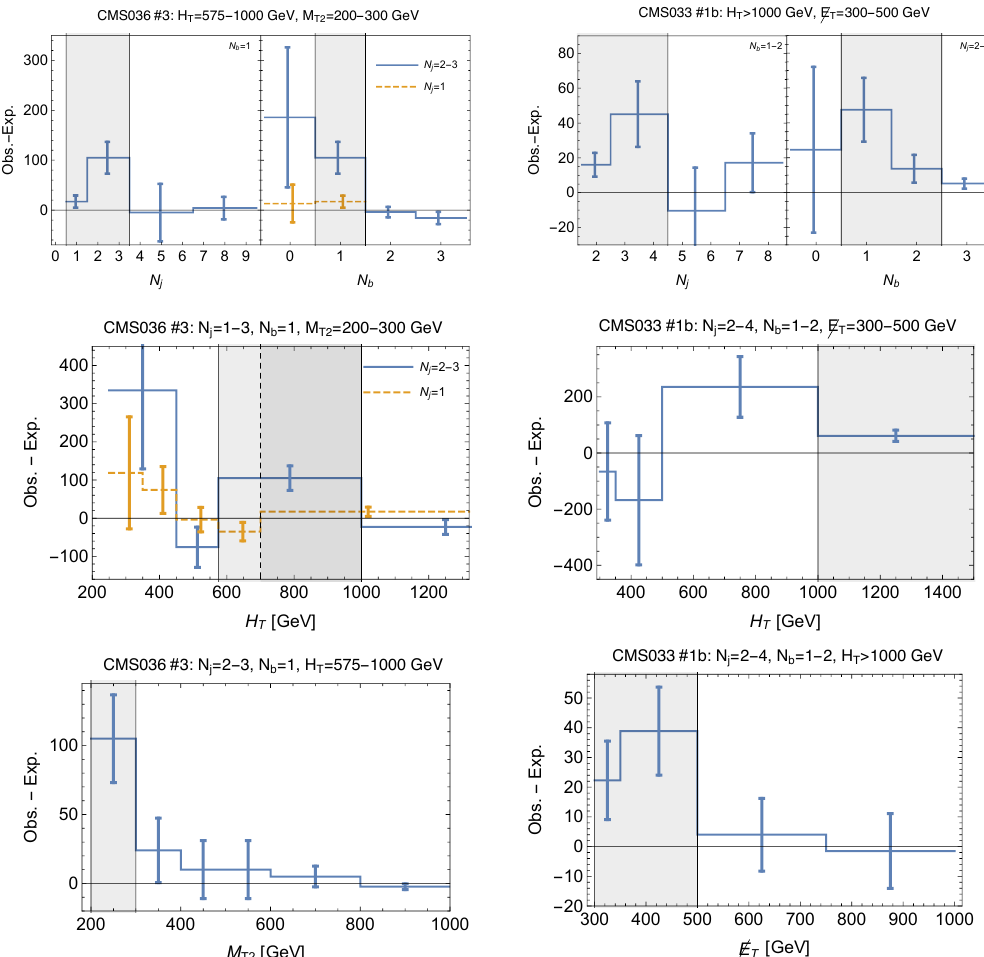
Figure 3 . Distributions of the residuals (observed minus expected counts) for the remaining excesses in tables 1 and 2, with error bars denoting the uncertainty, as explained in the text. The left column shows kinematic distributions for CMS036 ROI #3 while the right column displays CMS033 ROI #1b. The variables plotted and the color-coding are the same as in (cid:12)gure 2. second bin of the N = 1 distribution ( p j 0 = 350 (cid:0) 450 GeV) which only marginally j T increases the signi(cid:12)cance. Finally, the bottom plot shows the M distribution of the T 2 N (cid:21) 2 bins (note that M is not de(cid:12)ned for N = 1). j j T 2 (cid:15) In the right column, we show the kinematic distributions for the very similar CMS033 ROI #2, which is formed by signal regions with low H (cid:24) =E . Four separate signif- T T icant aggregations are possible, of which two are shown in solid blue (#2a), dashed yellow (#2b, which for presentation purposes is rescaled by a factor of 10). We do not plot aggregation #2c and #2d to avoid cluttering the (cid:12)gure: #2c is mostly degenerate with #2a, di(cid:11)ering only by the (cid:24) 100 events in the N = 5 (cid:0) 6 bins, j while #2d drops the highly populated N = 2 bin, but has similar shapes as #2a for j the other distributions. In the N ; N plots, we separately show the excess location j b